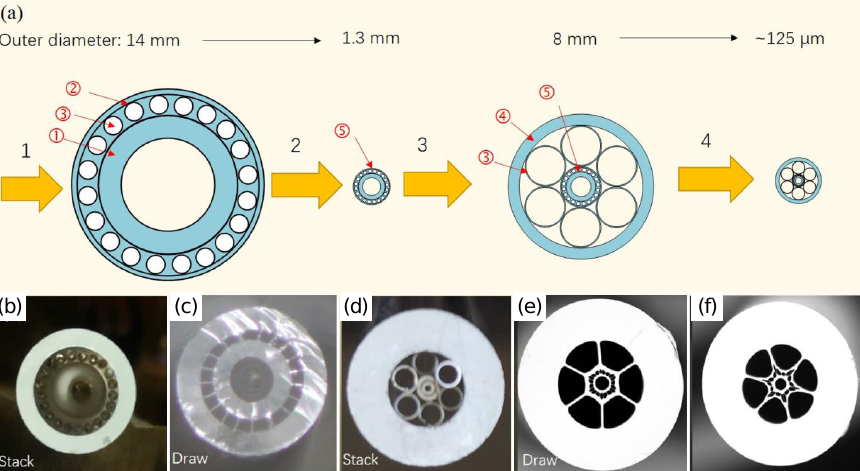
Figure 12. Fabrication of the proposed NC-RCF. ( a ) Schematic figure of the fabrication process using stack-and-draw method. ( b ) Stacked preform of the central cane. ( c ) Cross section of the intermedia cane. ( d ) Stacked preform of the NC-RCF. Scanning electron microscopic photo of the fabricated NC-RCF with ( e ) the thickness of ring core around 2.45 µ m, Adapted with permission from Ref. [39] © The Optical Society, and ( f ) the thickness of ring core around 2.65 µ m. Adapted with permission from Ref. [40] © IEEE.